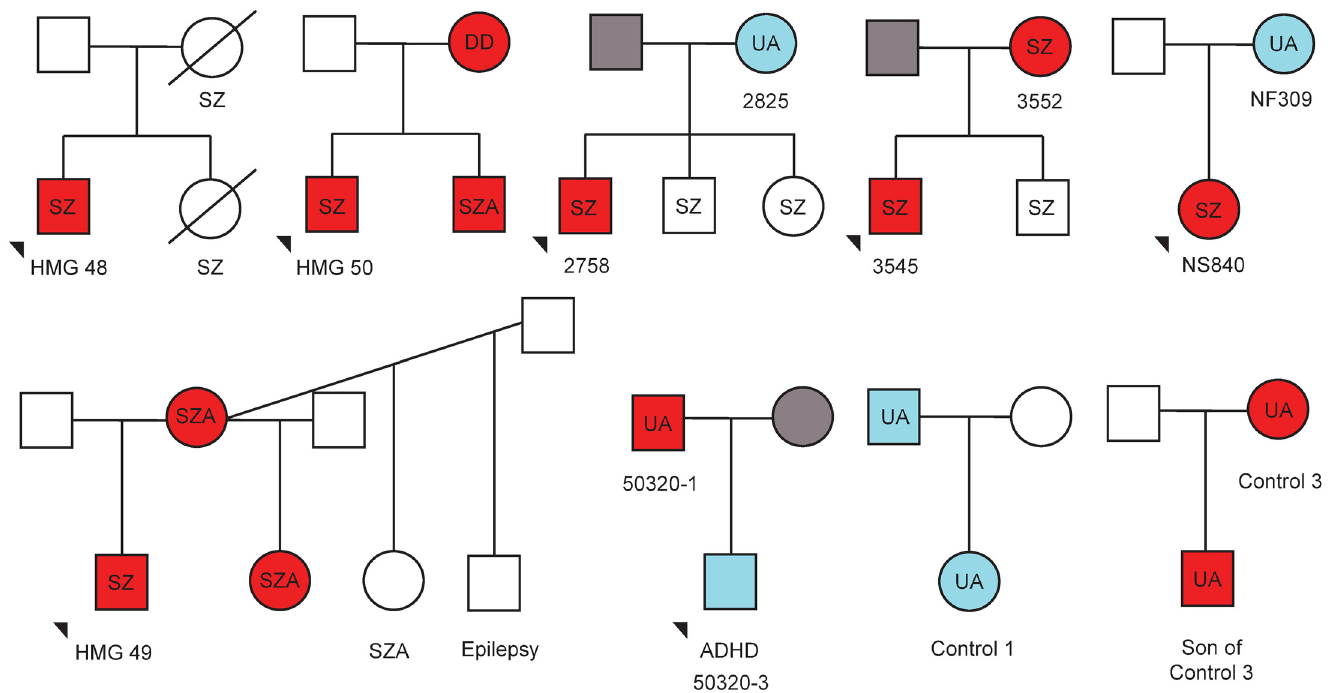
Fig 2. Family trees depicting transmission of 15q11.2-q13.3 duplications and neuropsychiatric phenotypes. Red fill indicates maternal duplications, blue indicates paternal duplications, and grey indicates no duplications. Samples where no DNA was available have no fill. Where DNA samples were available, parent of origin was determined using methylation-sensitive high-resolution melt curve analysis, or methylation-sensitive Southern Blot. Neuropsychiatric phenotype (detailed in S1 Table) is indicated as follows: SZ — schizophrenia; SZA — schizoaffective; DD — developmental delay; UA — unaffected. In addition, one individual was reported to have epilepsy and another ADHD.